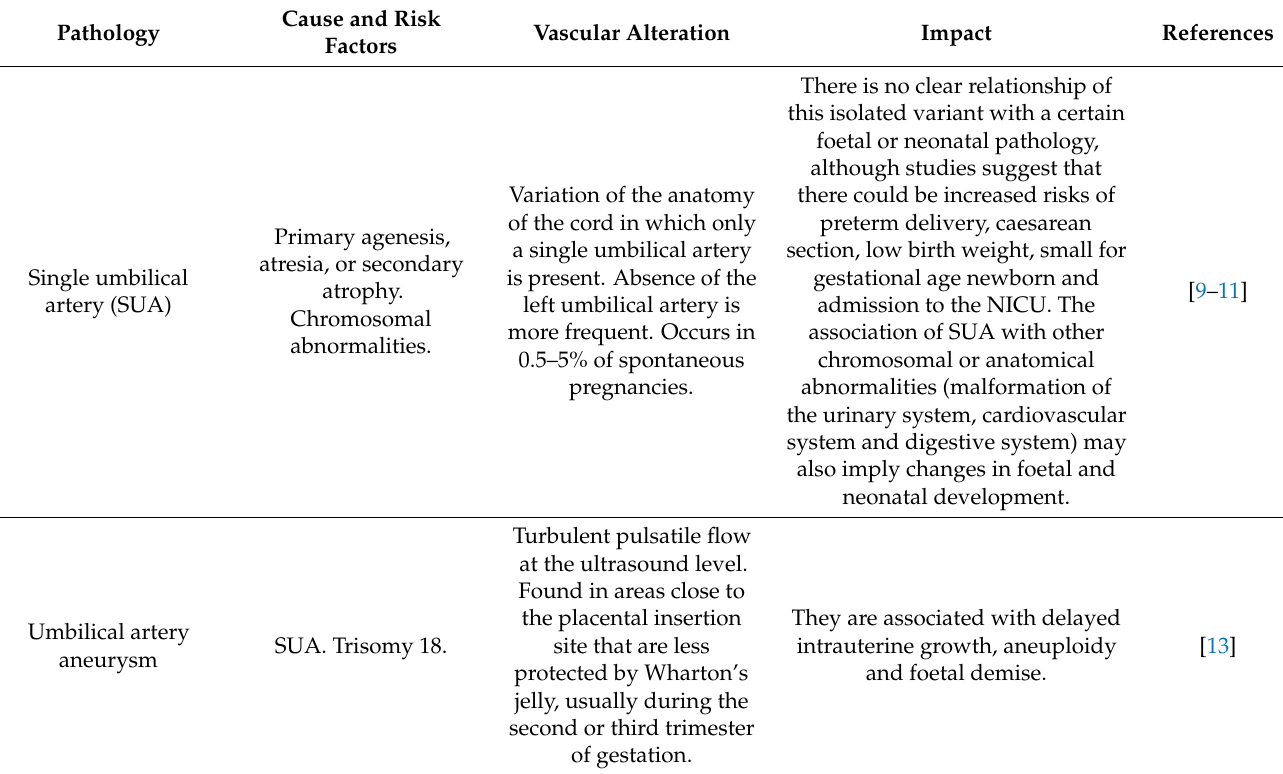
Figure 1. Histological description and vascular alterations observed in the umbilical cord or affecting the umbilical cord, along with the many maternofoetal consequences derived. Table 1. Main vascular alterations of the umbilical cord and their impact on the foetal well-being and the newborn.